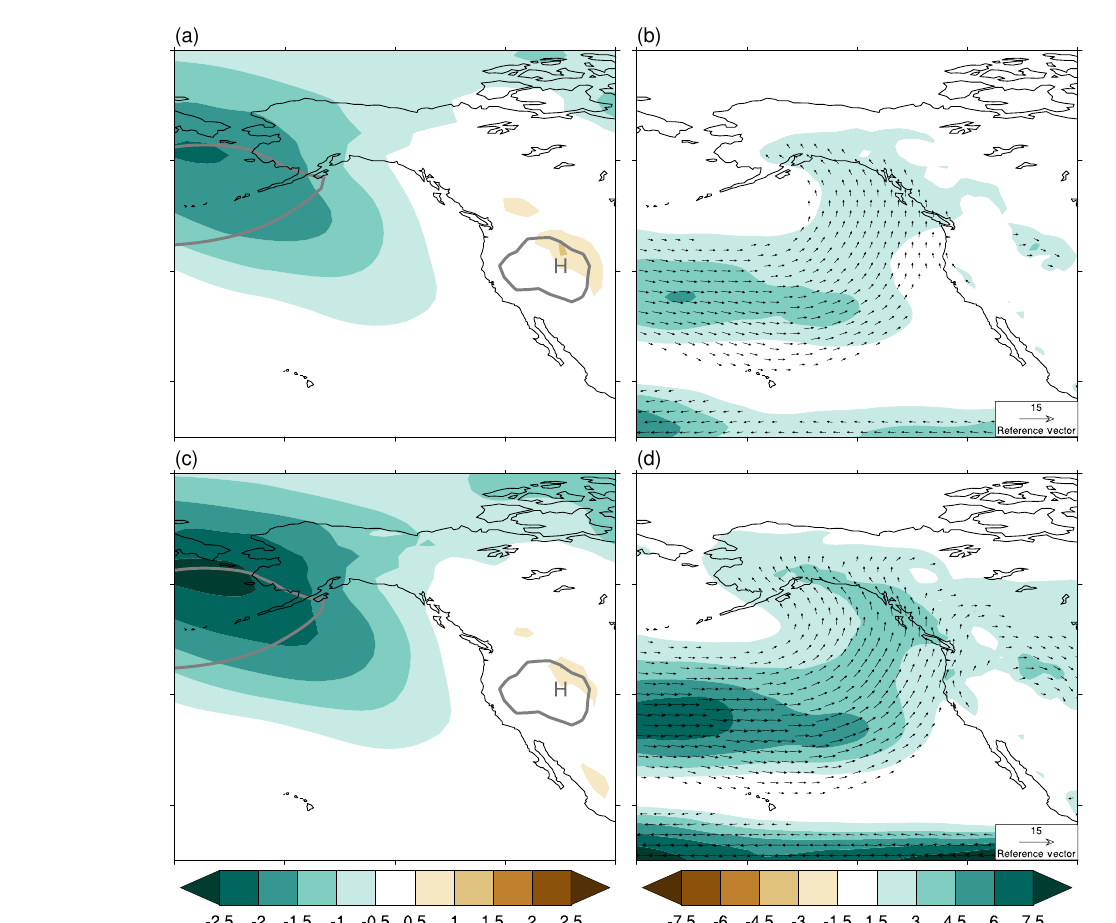
Figure 16. Wintertime (DJF) response of sea level pressure and moisture flux in (a, b) 1.5 ◦ C and (c, d) 2.0 ◦ C relative to PD in NorESM1- Happi. (a, c) MSLP response (shading; unitshPa) along with the climatological 1000 and 1025hPa isobars from the PD experiment (grey contours). (b, d) 850hPa specific humidity flux response (shading and vectors; units gkg − 1 ms − 1 ). Only vectors with a magnitude greater than 2gkg − 1 ms − 1 are